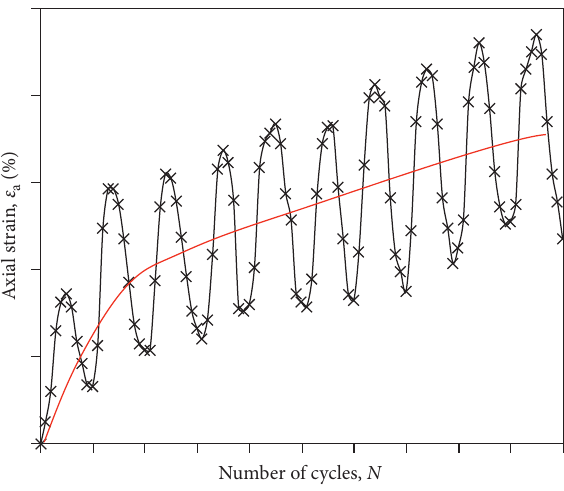
Figure 8: The simplified treatment